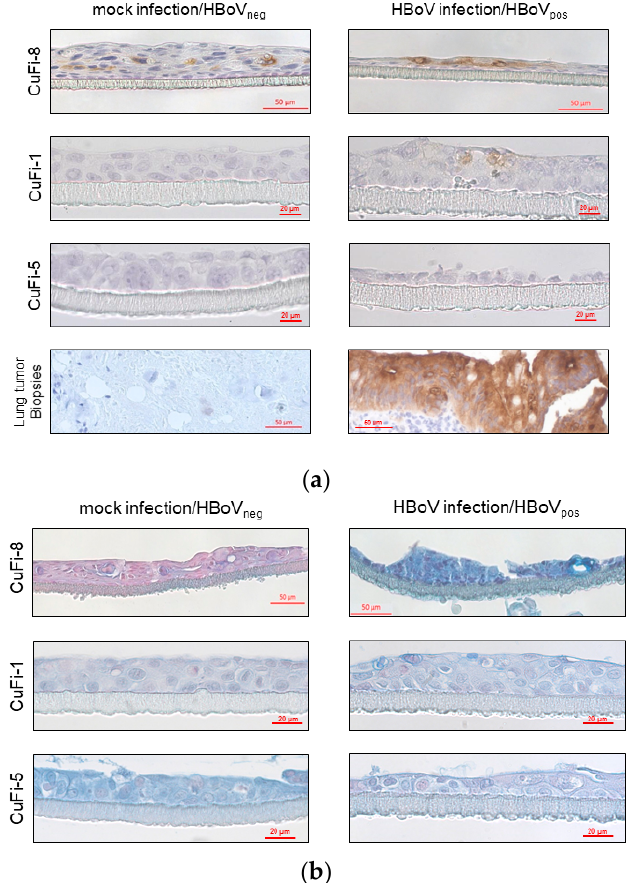
Figure 3. Immunohistochemical staining of CuFi-8 air–liquid-interface cultures. ( a ) Scheme 8. cells and HBoV-positive lung tumor biopsies, whereas mock-infected CuFi-8 cultures, as well as HBoV-negative lung tumors, were CEA-negative. CuFi-1 and Cufi-5 cells were not CEA-positive at all. ( b ) PAS–Alcian blue staining reveals higher production of acid mucins in CuFi-8 cells compared to those in CuFi-1 and CuFi-5 cells in general. Beyond that, there is an increased expression of acid mucins after HBoV infection in CuFi-8 cells.